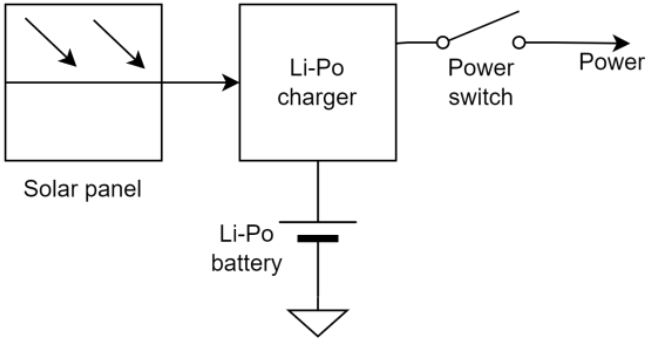
Figure 3. Block diagram of the power supply module of the sensor node.